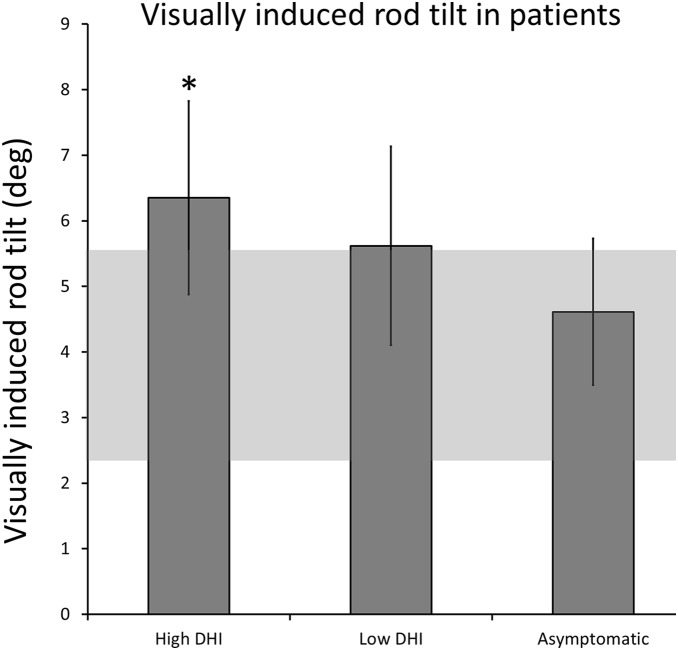
Visually induced rod tilt for all patient groups and normals.Figure showing visually induced rod tilt (mean, ±SE) for all patient groups (High DHI; Low DHI; Asymptomatic). Shaded grey area represents 95% confidence interval of the mean for normal controls. Note, rod tilt values for Low DHI and Asymptomatic patient groups are within normal range, where as High DHI patients show significantly higher than normal rod tilts in the moving disk condition.